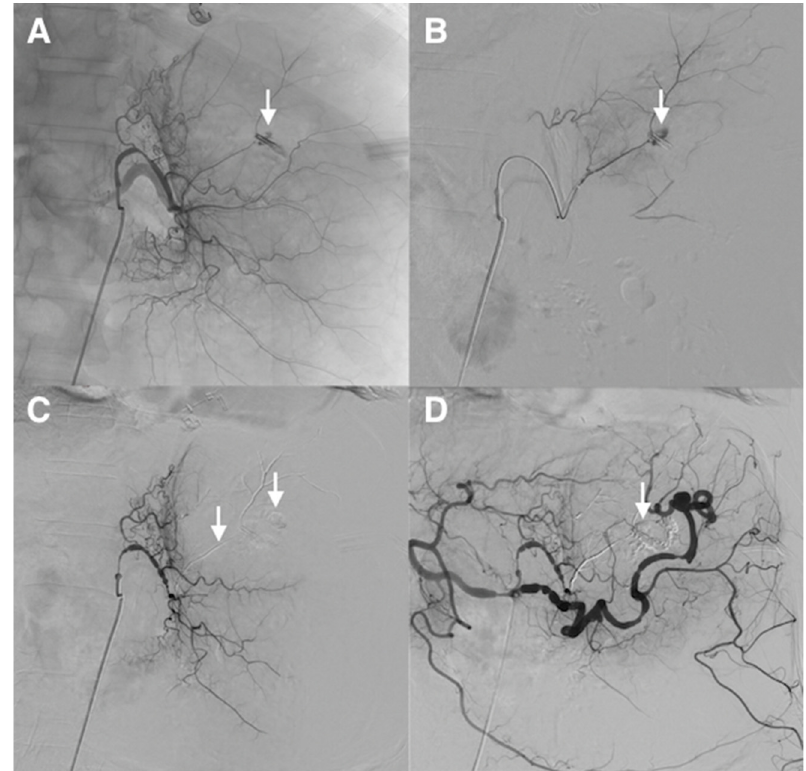
Figure 7. Refractory upper gastrointestinal hemorrhage from a gastric ulcer of the less curvature in a 64-year-old patient with coagulation disorders and hemodynamic instability. ( A ) Catheterism of the left gastric artery demonstrated extravasation of contrast medium from a small feeding branch of the less curvature ( arrow ). ( B ) Superselective angiogram of the bleeding artery, guided by an endoscopic metallic clip, confirmed active bleeding ( arrow ). ( C ) After selective microcatheterism, hemorrhage was controlled after superselective embolization of the feeding artery using a MagicGlue ® /Lipiodol ® mixture (1:3 ratio) ( arrows ). ( D ) Final control angiography showed successful superselective occlusion of the bleeding arterial branch, respecting collaterals ( arrow ). The patient stopped to bleed immediately.